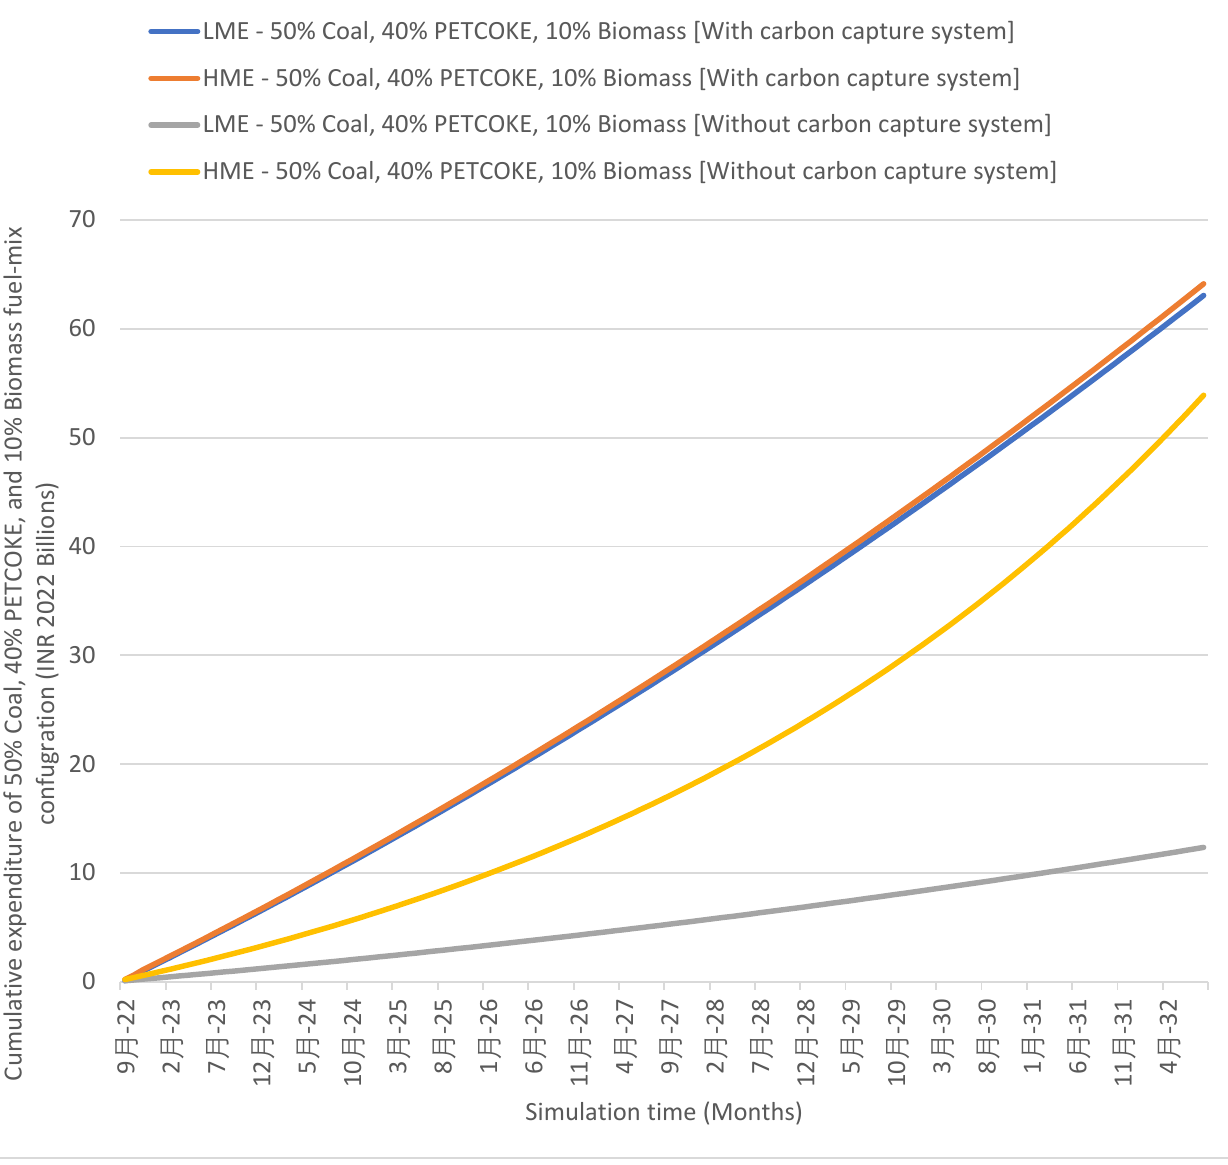
Figure 12. The effect of carbon capture system on the cumulative expenditure of 50% Coal, 40% PETCOKE, and 10% Biomass fuel mix under LME and HME scenarios.